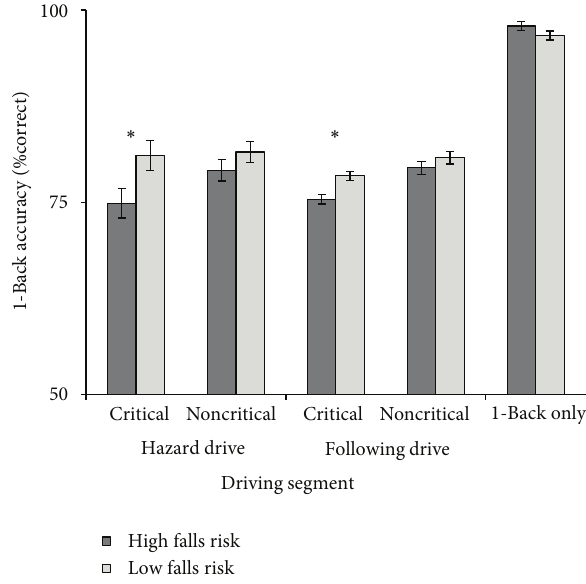
Figure 4: 1-Back accuracy. Accuracy on the 1-Back task in critical and noncritical segments of the hazard and following drives and in the single-task (1-Back only) condition. Error bars represent one standard error of the mean. ∗ 𝑃 < .05